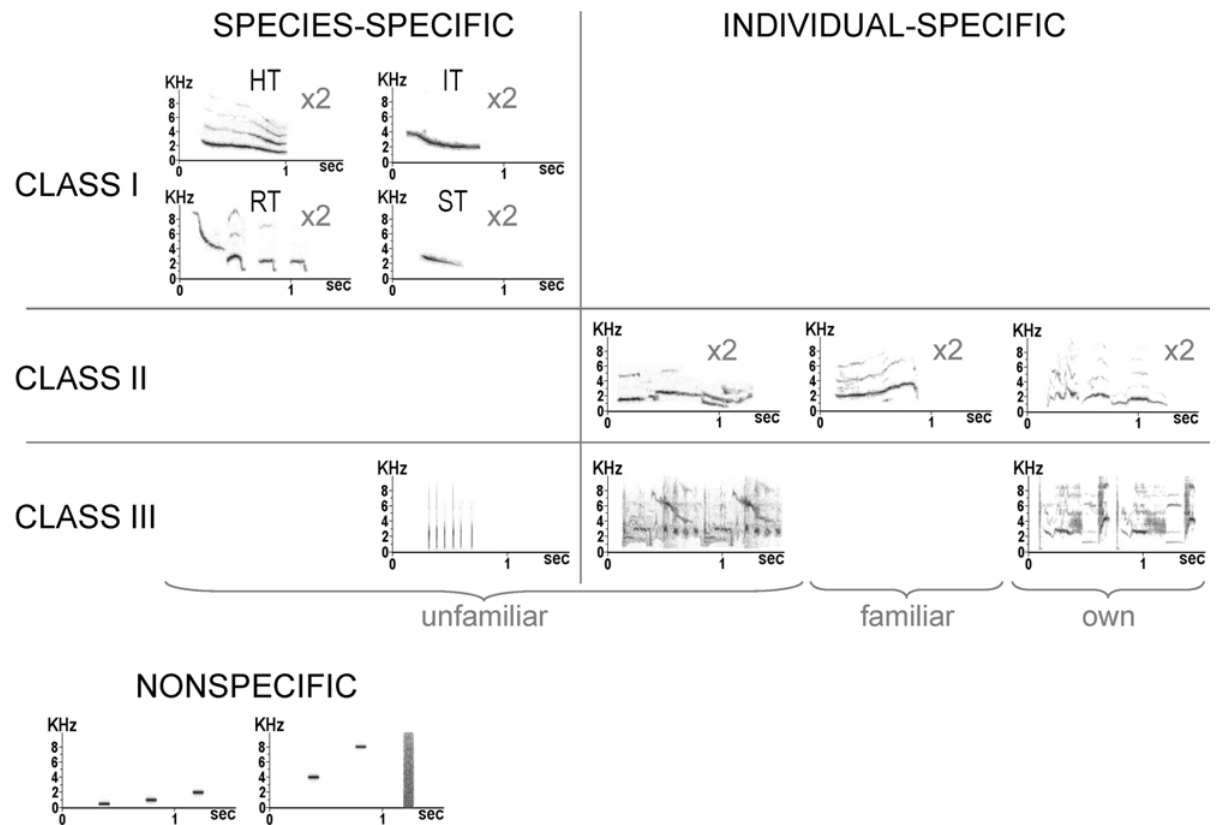
Figure 1. Stimuli used to test the neurons, with some examples of sonograms. Class-I songs are whistles that are produced by all male starlings and that are used in species and population recognition, as confirmed by playback experiments with dialectal variants [29,30]. Among these songs, 4 themes can be distinguished (from left to right and from top to bottom): harmonic themes (HT), inflection themes (IT), rhythmic themes (RT), and simple themes (ST). Two unfamiliar variants of each theme were used. Class-II songs are individual-specific whistles that are used in long-distance recognition, and that can be shared, in captivity, by a few socially affiliated birds [31]. Two exemplars from the tested bird (own), 2 unfamiliar and 2 familiar exemplars were used. A familiar exemplar was a song produced by a bird that had been caught at the same time as the tested bird, and that had spent 2 years in the same aviary. Class-III songs, also called warbling, are mainly composed of highly individual motifs but also of some motifs common to all starlings [32,33]. They are used in short distance communication. One species-specific motif (clicks) and two individual-specific motifs (one unfamiliar and one from the tested bird) were used. Finally, 5 pure tones (0.5, 1 , 2, 4 and 8 kHz) and a white noise were used as artificial non- specific stimuli. The stimuli (n=23) were the same for all the birds except those corresponding to the bird’s own songs and to the familiar songs, which changed from one bird to another.